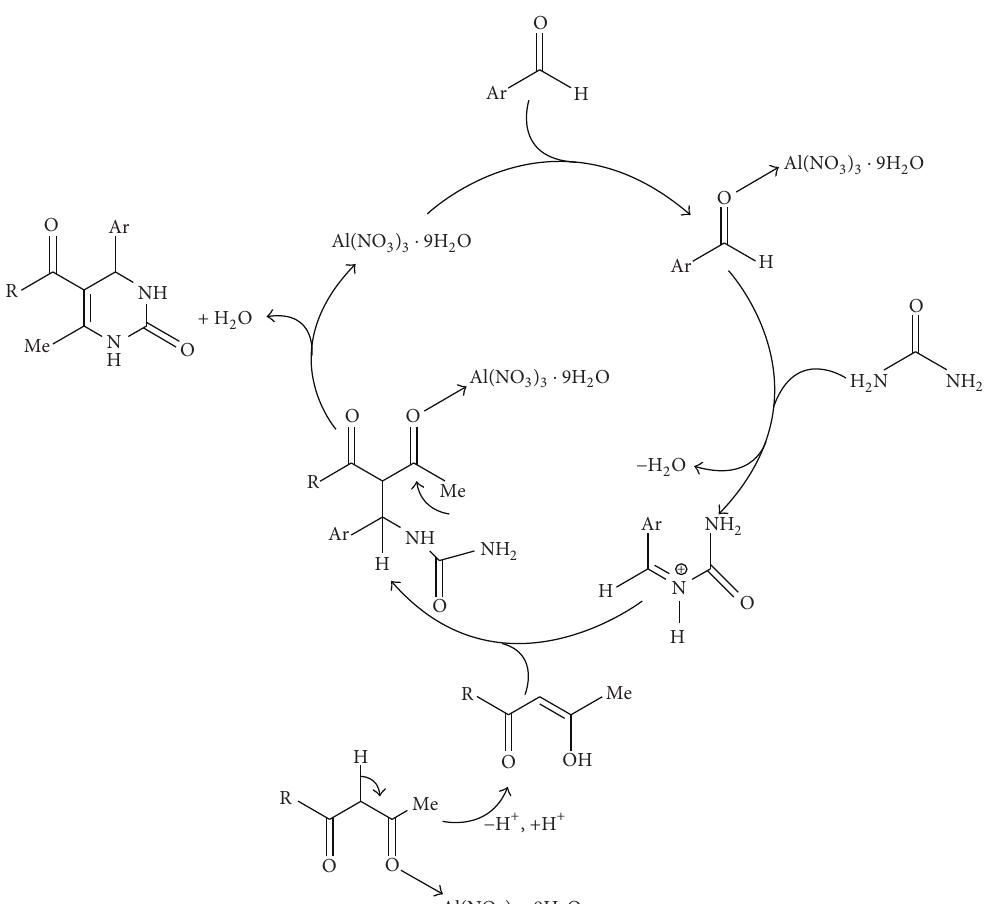
F 2: Proposed mechanism for the aluminum nitrate-catalyzed Biginelli